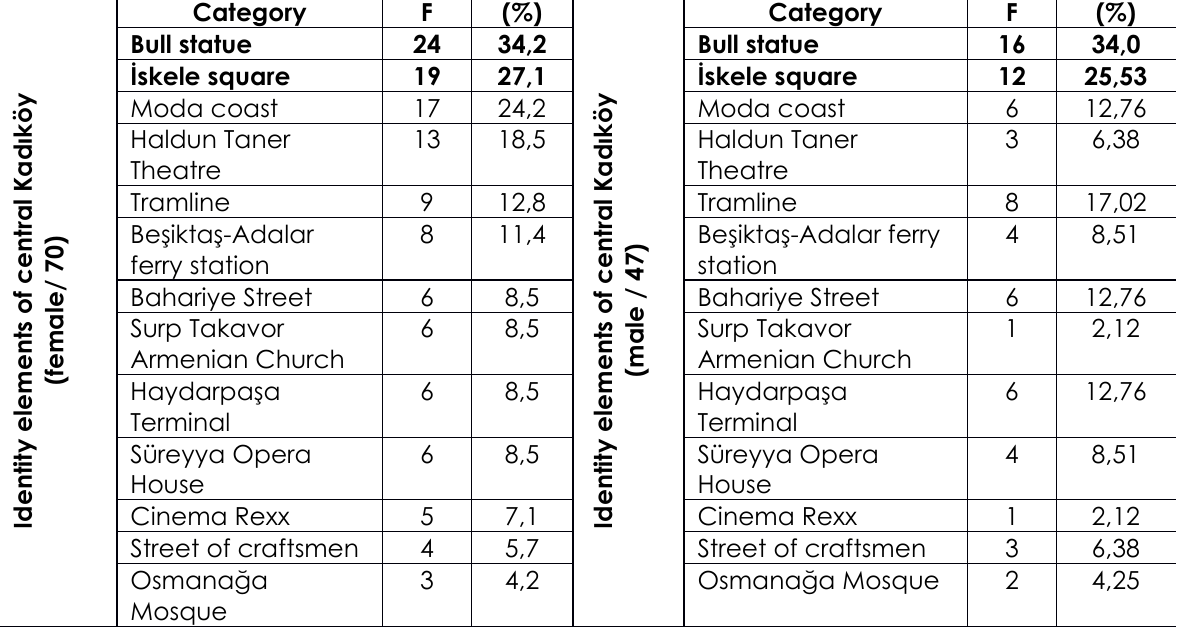
Figure 3. Identity Map Created by the Researcher Based on the Answers of the Survey (Developed by Author). In line with the results of the survey, frequency of use were established and comparative analyses based on gender, age, presented in the tables below. duration of settlement in and Table 3. The Analysis of Identity Elements via Variable of